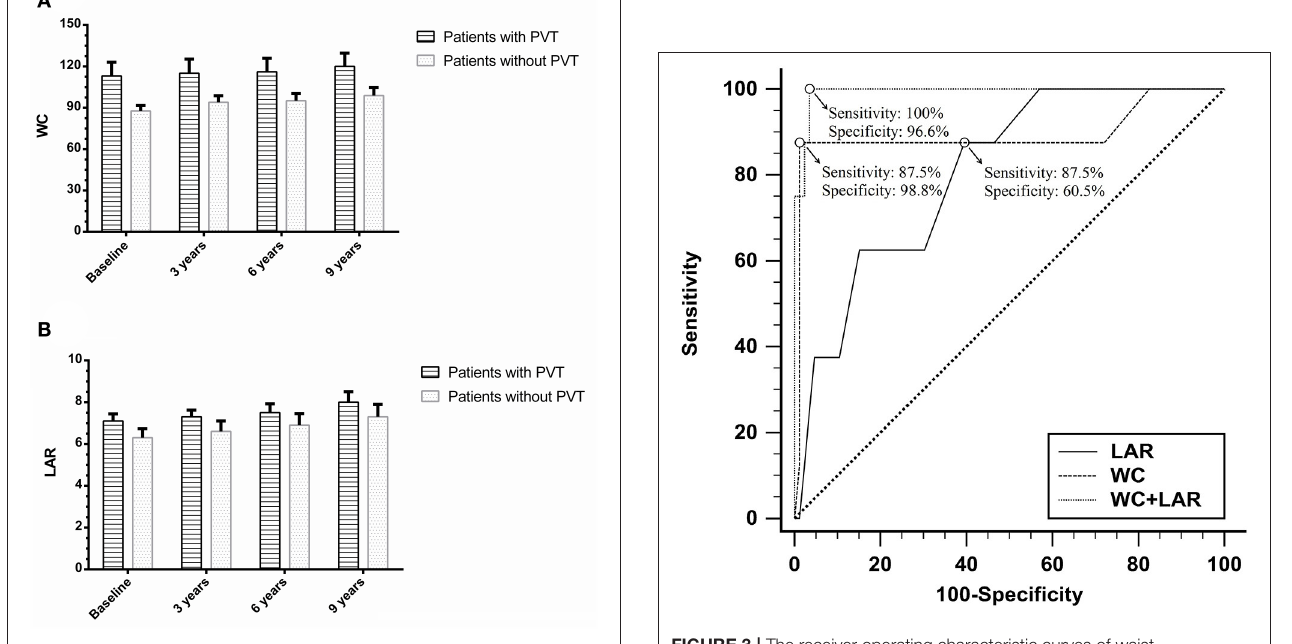
FIGURE 2 | Waist circumference (A) and leptin/adiponectin ratio (B) changes in patients with and without portal vein thrombosis.